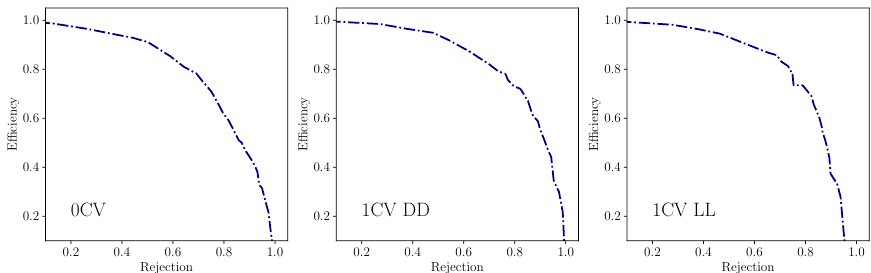
Figure 5: ROC curves for the test data using the different topologies. 0CV NN (left), 1CV DD NN (center),1CV LL NN (right)